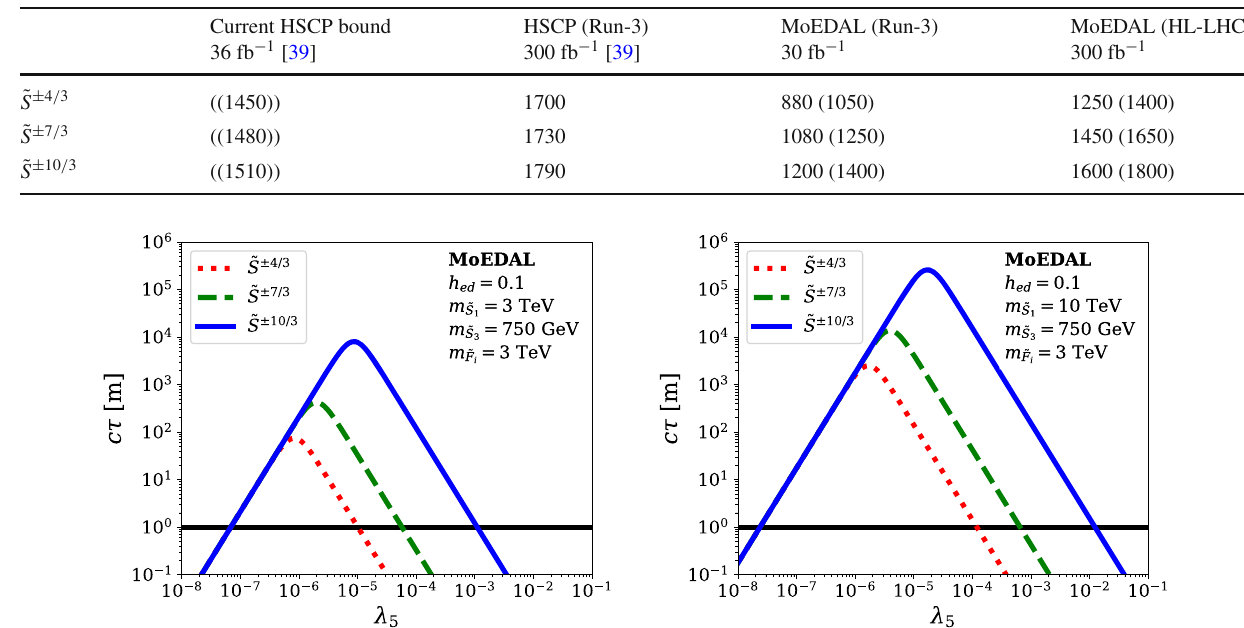
Table 3 Summary for the model-independent mass reaches (in GeV) of the multi-charged particles in Model-2 by MoEDAL (2nd and 3rd columns). In the first column, the numbers in the double-brackets show the estimatedmass bounds obtained in [39] by rescalingthe 8 TeV CMS result [40] to the 13 TeV LHC with L = 36 fb − 1 . The second column